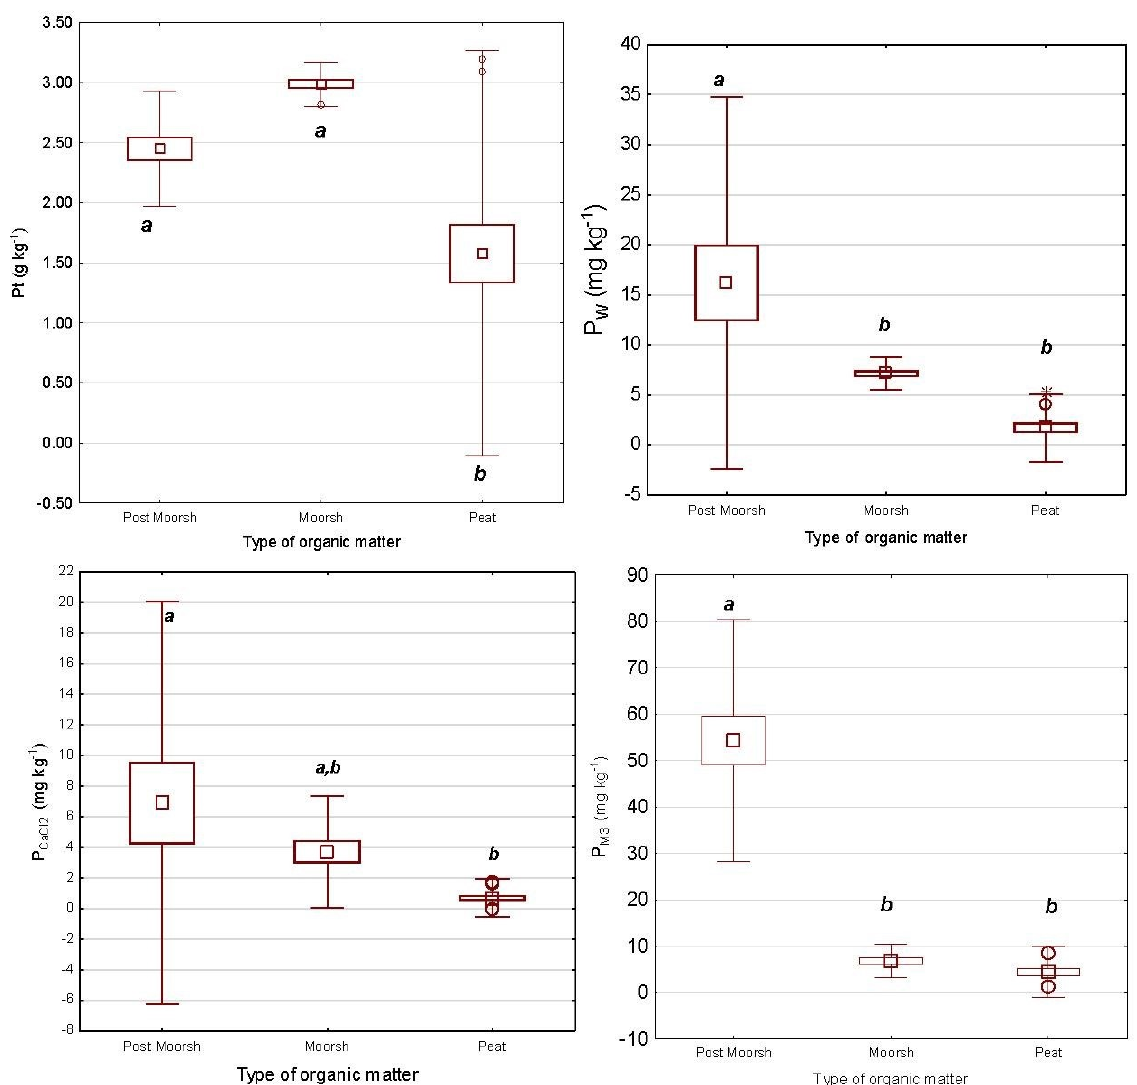
Figure 5. Comparison of Pt and soluble P forms (Pw, P CaCl2 , P M3 ) 1 in groups of organic horizons depending on the degree of OM transformation: Peat, Moorsh, Post Moorsh horizons. Explanation: central squares–mean values; boxes–mean values ± standard errors; whiskers—mean values ± 2*standard deviations; circle—outliers; asterisk—extreme; letters a, b, c—significance of differences (homogeneous groups of means) by RIR Tukey test (at p < 0.05). 1 Pt—total P; Pw—water-extractable P forms; PCaCl2—easily soluble P extracted in 0.01 mol/L CaCl2 solution; PM3—available P by the Mehlich III method.